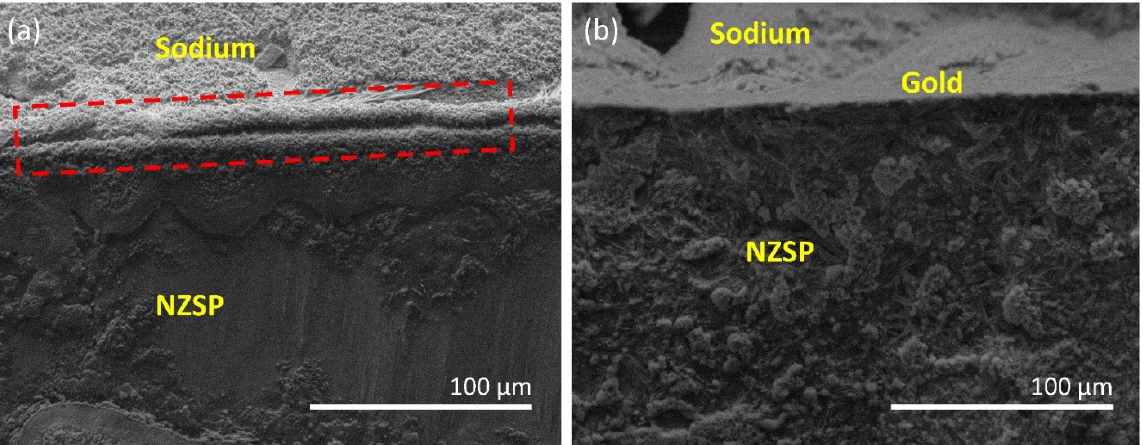
Figure 6. Ion-milled cross-sectional SEM of ( a ) a fresh Na||NZSP cell exposing the poor wettability between the sodium and NZSP and ( b ) a fresh Na||Au-NZSP cell interface revealing enhanced sodium wettability with almost no interfacial gaps.